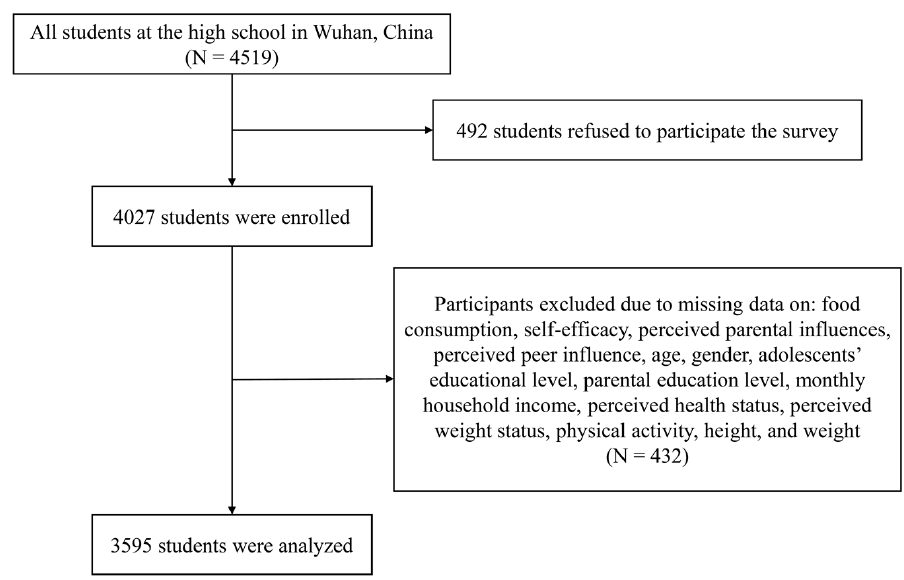
Figure 1. Flow chart of participants.